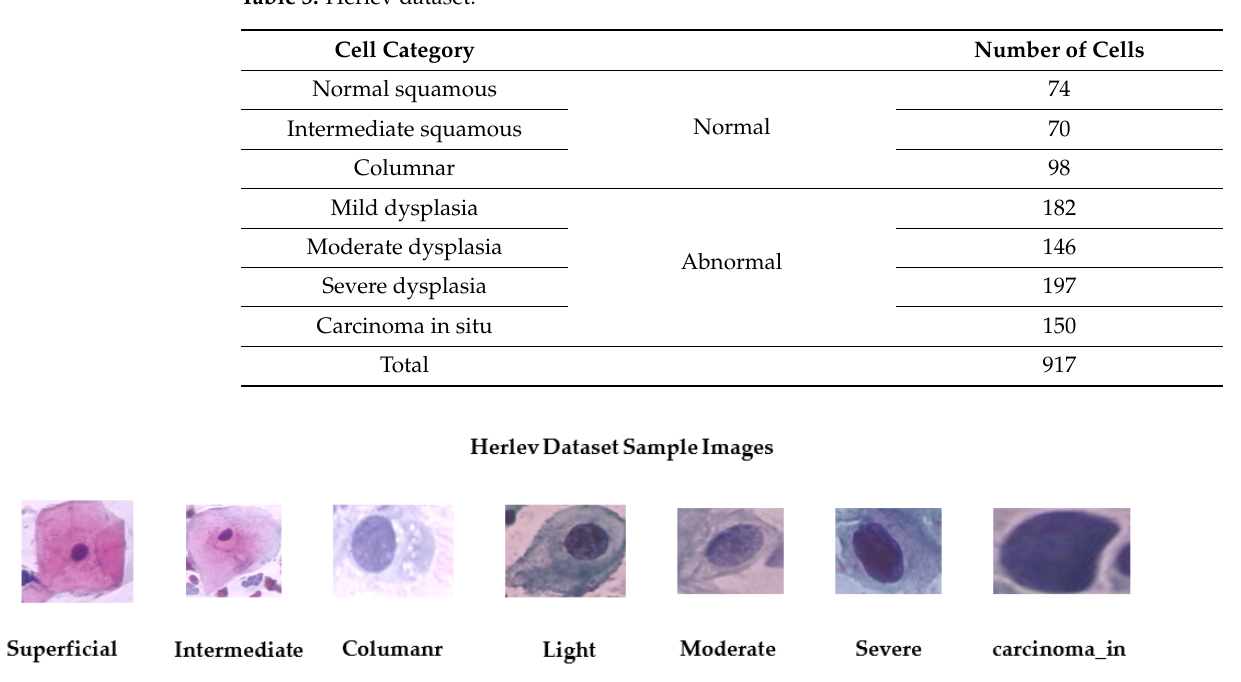
Figure 4. Sample images from Herlev dataset.